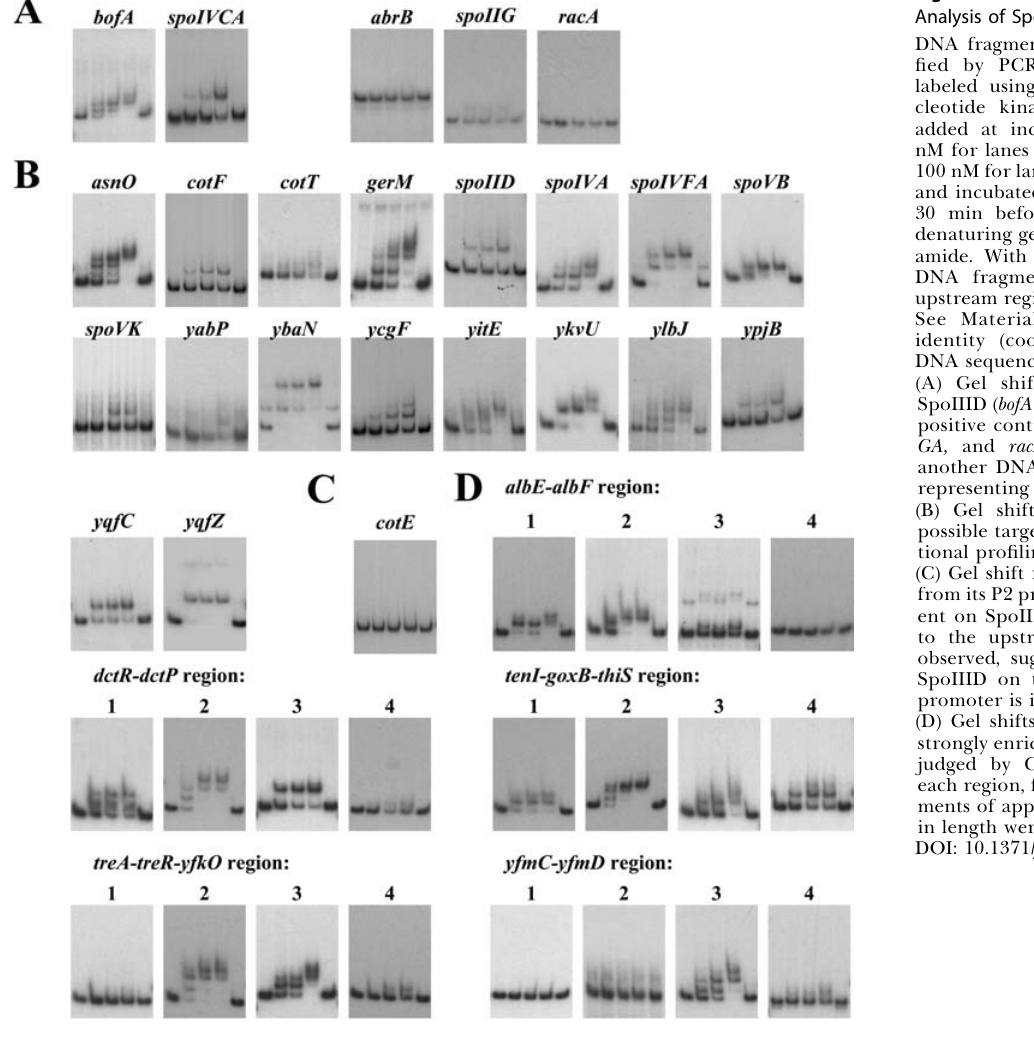
Figure 3. Gel Electrophoretic Mobility-Shift Analysis of SpoIIID Binding DNA fragments of interest were ampli- fied by PCR, gel-purified, and end- labeled using [ c - 32 P]-ATP and polynu- cleotide kinase. Purified SpoIIID was added at increasing concentrations (0 nM for lanes 1 and 5, 50 nM for lane 2, 100 nM for lane 3, and 200 nM for lane 4) and incubated at room temperature for 30 min before loading on to a non- denaturing gel containing 6% polyacryl- amide. With the exception of (D), the DNA fragments corresponded to the upstream regions of the indicated genes. See Materials and Methods for the identity (coordinates) of the specific DNA sequences used in the